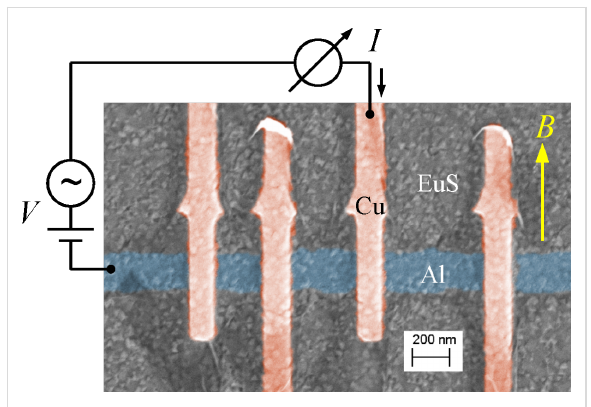
Figure 4: False-color scanning electron microscopy image of the sam- ple and experimental